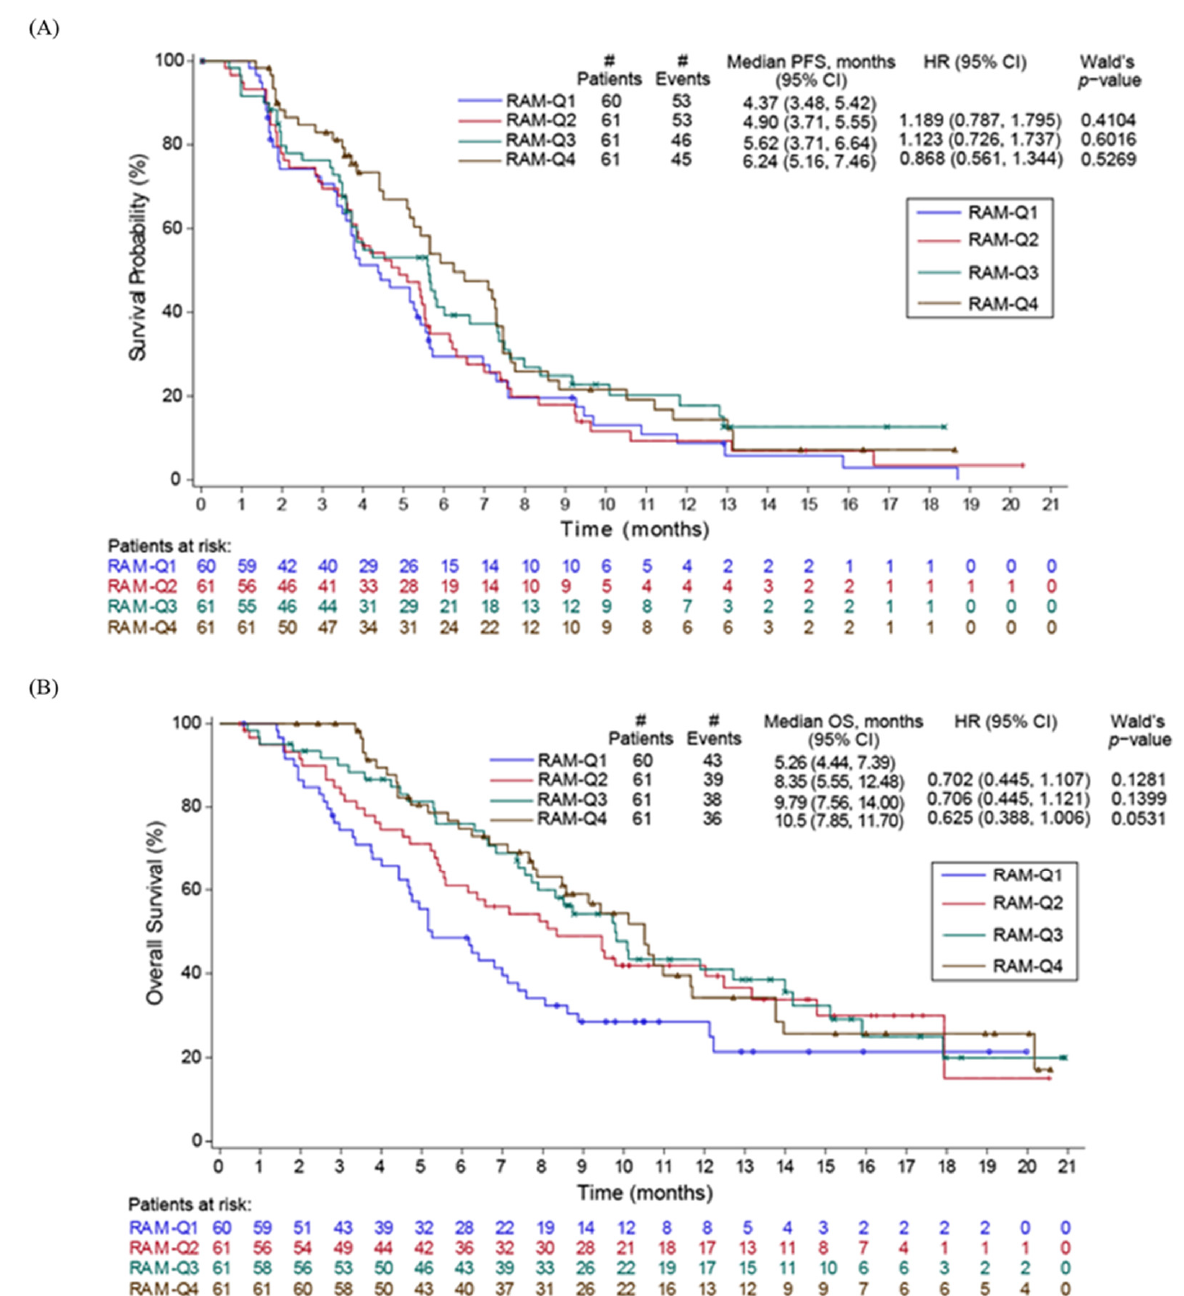
Figure 4. PFS ( A ) and OS ( B ) of JVCZ safety population by ramucirumab C min,1 quartiles. Abbreviations: C min,1 —serum minimum concentration; OS—overall survival; PFS—progression-free survival.